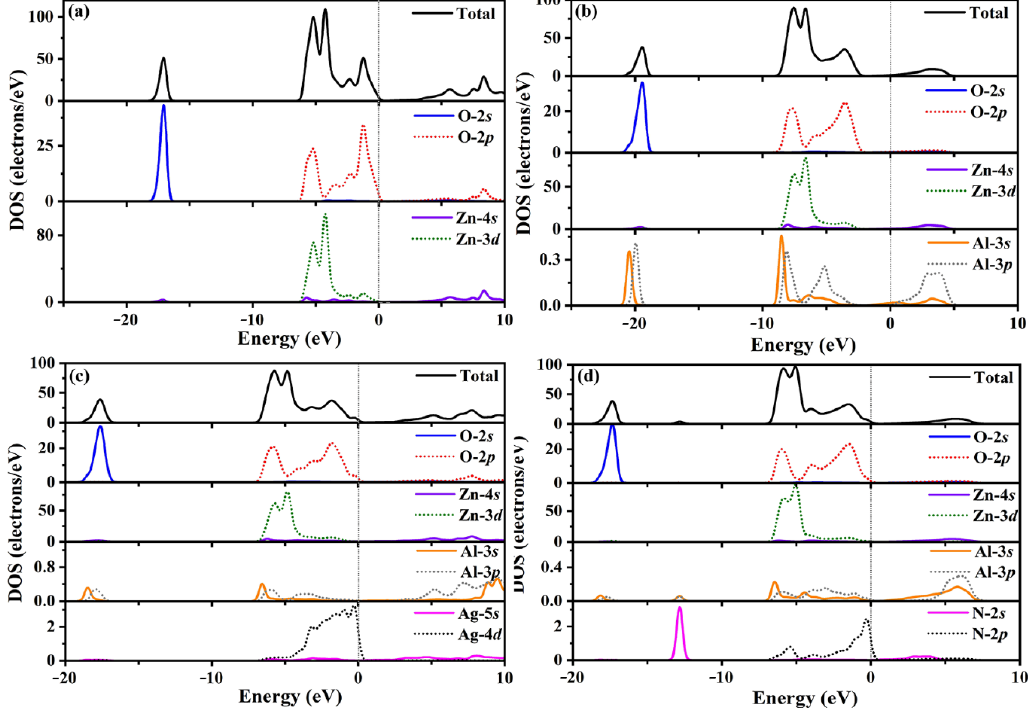
Figure 5. The density of states (DOS) and partial density of states (PDOS) of ZnO ( a ), metal single doping ZnO (Al-ZnO) ( b ), metal/metal co-doping ZnO (Al/Ag-ZnO) ( c ), and metal/non-metal co-doping ZnO (Al/N-ZnO) ( d ), respectively. The Fermi level is marked by a gray dashed line.